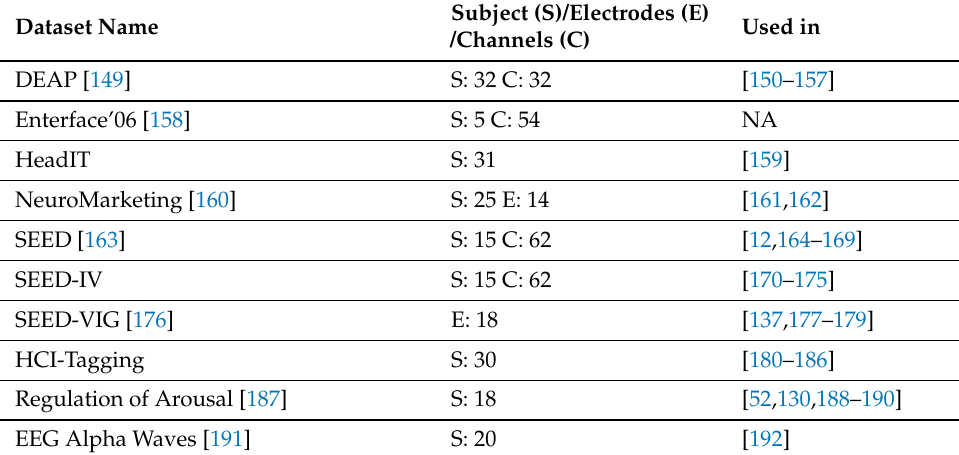
Table 4. A table of different types emotion recognition dataset of BCI.